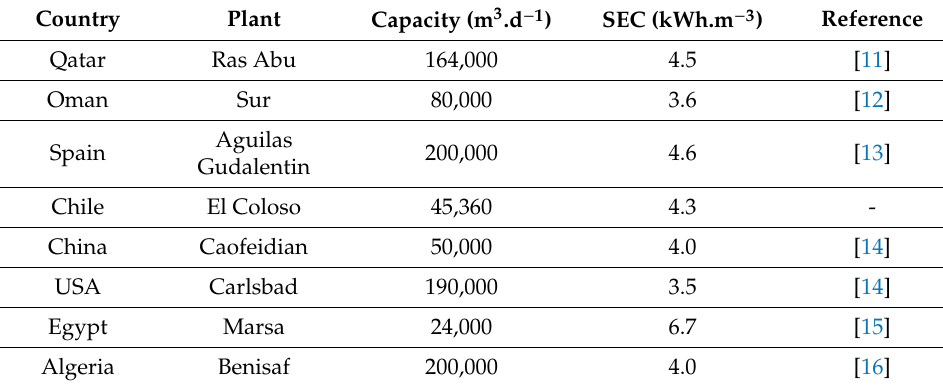
Table 2. Specification of some selected sea water reverses osmosis (SWRO) desalination plants working in single stage configuration in di ff erent countries. Capacity and specific energy consumption (SEC) of reverse osmosis (RO) system are listed as reported by Kim et al. [10]. Country Plant Capacity (m 3 .d − 1 ) SEC (kWh.m − 3